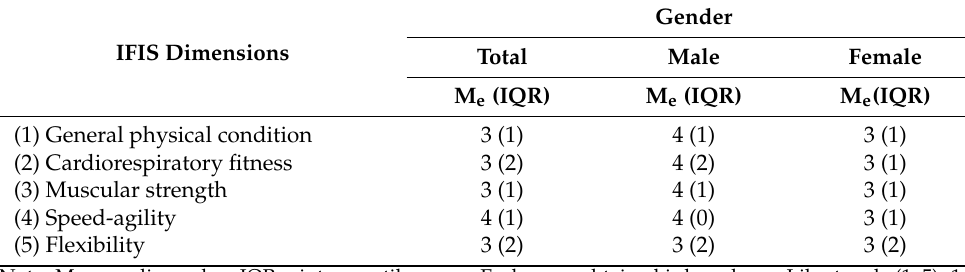
Table 3. Descriptive statistics by sex of the IFIS